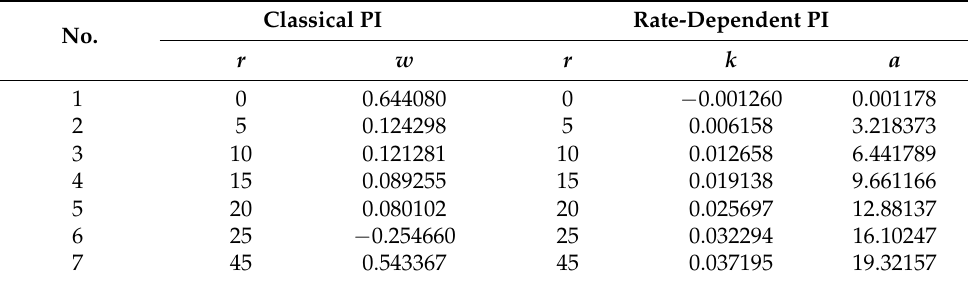
Figure 5. Hysteresis curve measured and hysteresis modeling based on classic a Prandtl–Ishlinskii (PI) method and a rate-dependent PI model. Table 2. Identified parameters.